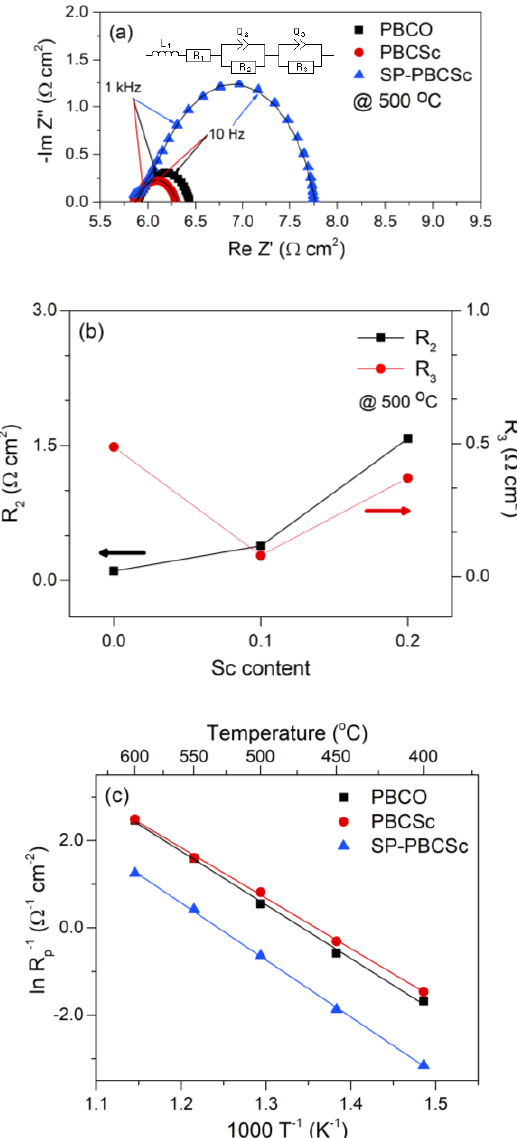
Figure 5. ( a ) Experimental and fitted impedance spectra of symmetrical cells with PBCO, PBCSc, and SP-PBCSc at 500 °C. ( b ) Comparison of fitted charge-transfer resistance (R 2 ) and non-charge-transfer resistance (R 3 ) for samples at 500 °C. ( c ) Arrhenius plot of the polarization resistances for samples.